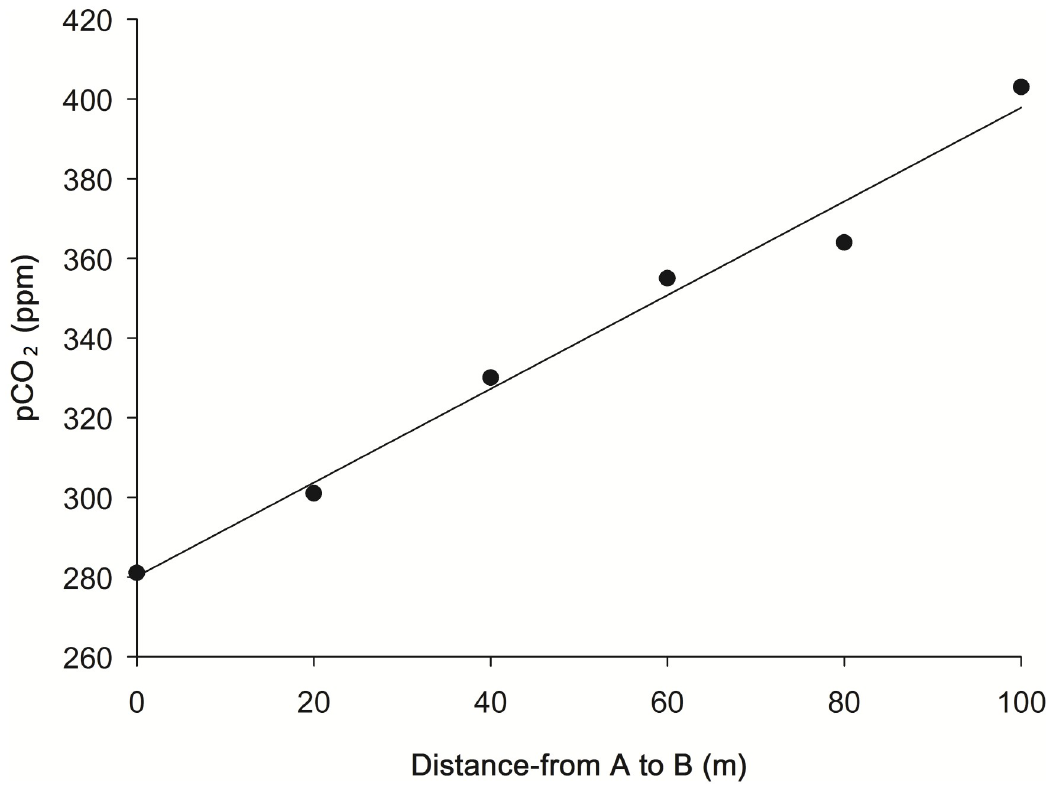
Fig 2. pCO 2 gradient in a transect on the reef flat perpendicular to the coastline at Wanliton. A: sea end, B: coast